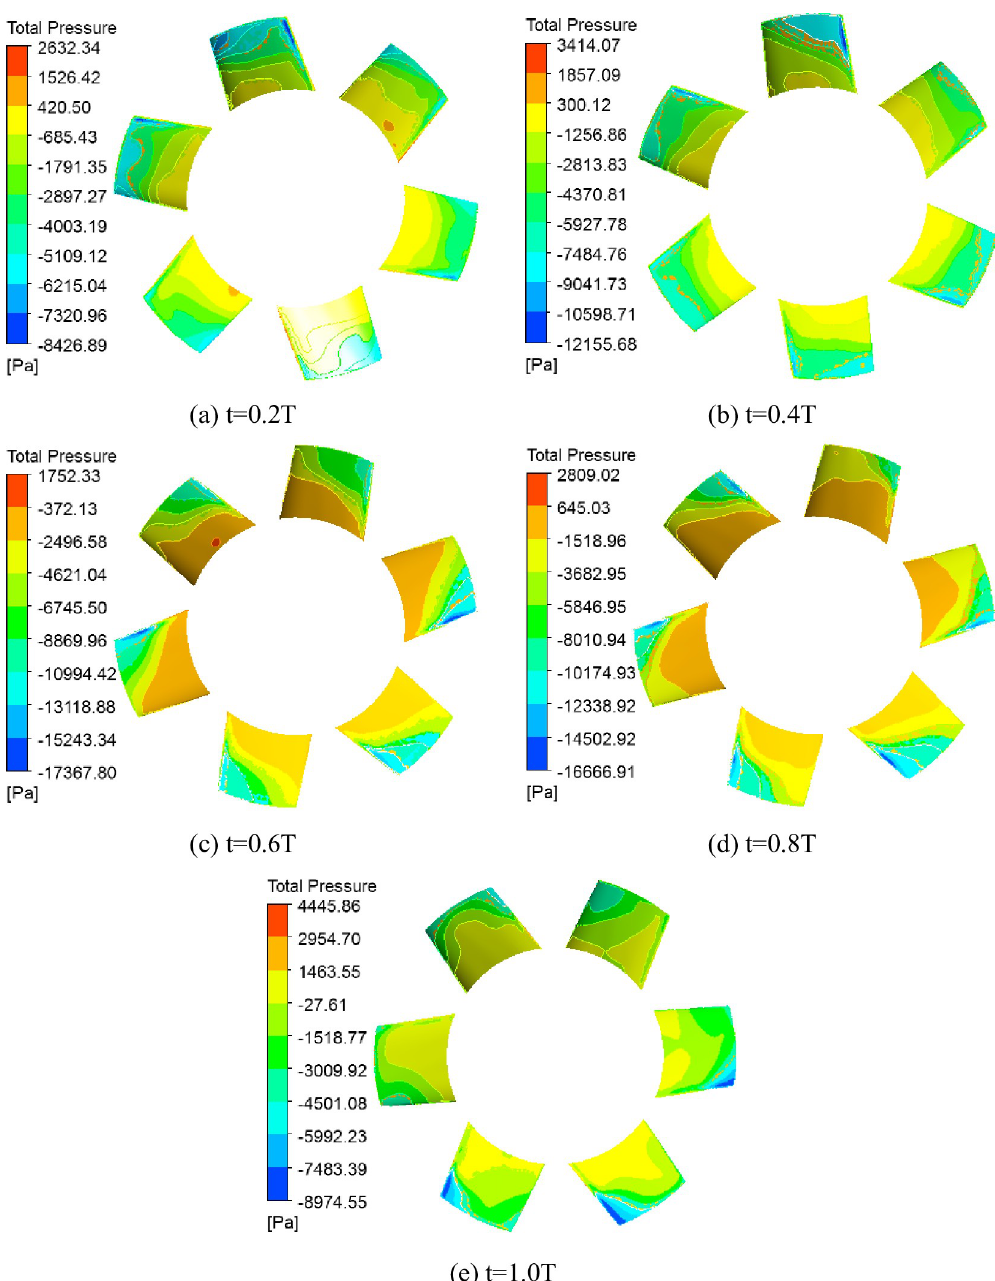
Fig 6. Total pressure distribution of second-stage blade suction surface under F =